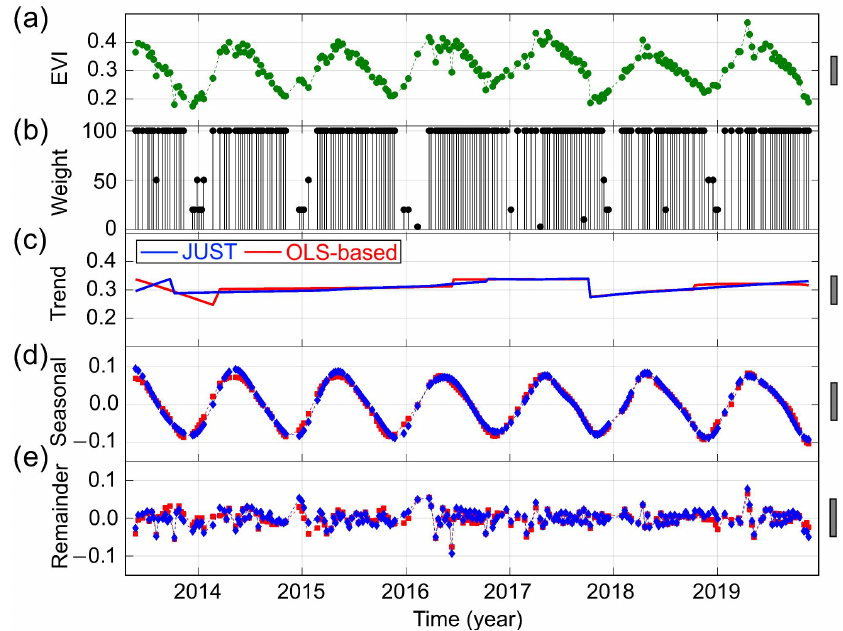
Figure 14. Decomposition of a real-world unequally spaced EVI time series into trend, seasonal, and remainder components. ( a ) EVI time series corresponding to pixel A shown in Figure 13c, ( b ) the weights associated with the time series values derived from the PQA band, and ( c – e ) the estimated trend, seasonal, and remainder components. The solid bars with the same data range are displayed on the right-hand side of the plot to help comparison.